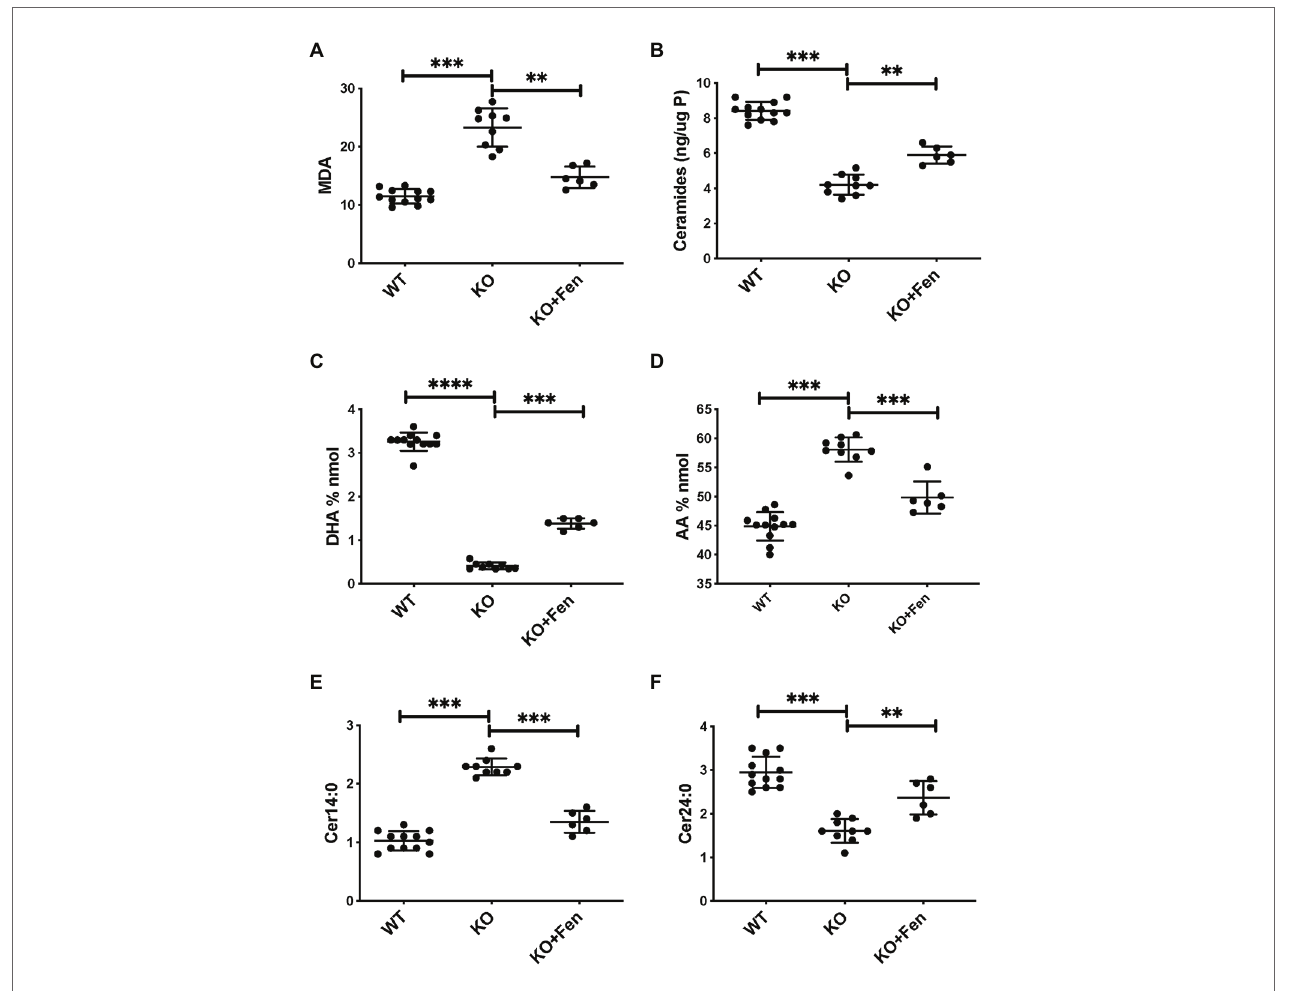
FIGURE 3 | Oxidative stress and abnormal lipid balance in CFTR KO PIG bronchial cells in air-liquid interface (ALI) culture is partially corrected by Fenretinide. (A) malondialdehyde (MDA) pmol/nmol fatty acid. (B) Total ceramides in CF HBEC-ALI. (C) DHA levels and (D) AA levels (% nmol total fatty acids). (E) Long-chain ceramide (CER14:0) and (F) Very long-chain ceramide (CER24:0) expressed as pmol/nmol phosphate. All parameters show significant differences when comparing CFTR KO ( N = 9) to WT ( N = 12), and CFTR KO filters treated with fenretinide ( N = 6) in parallel experiments ( **** P adj < 0.001, unpaired ANOVA, Dunnet, using KO as reference control). Results are from two CFTR KO and two wildtype newborn pigs cultured in parallel in two separate experiments. Symbols in the figures represent data from single filters, average ±